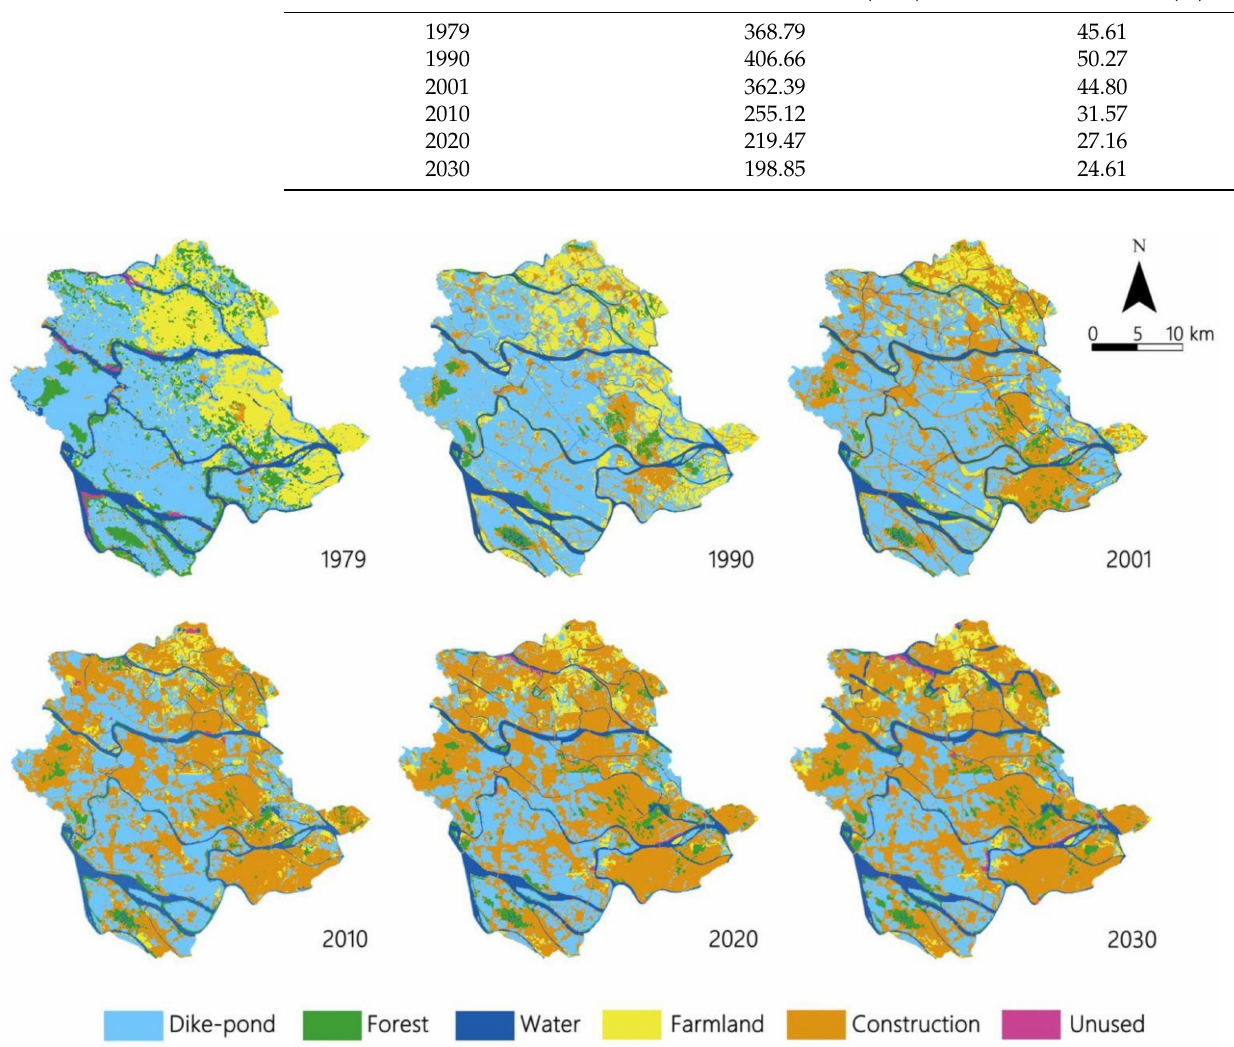
Figure 5. Spatial evolution of land use change from 1979 to 2020 and simulation of 2030 in Shunde